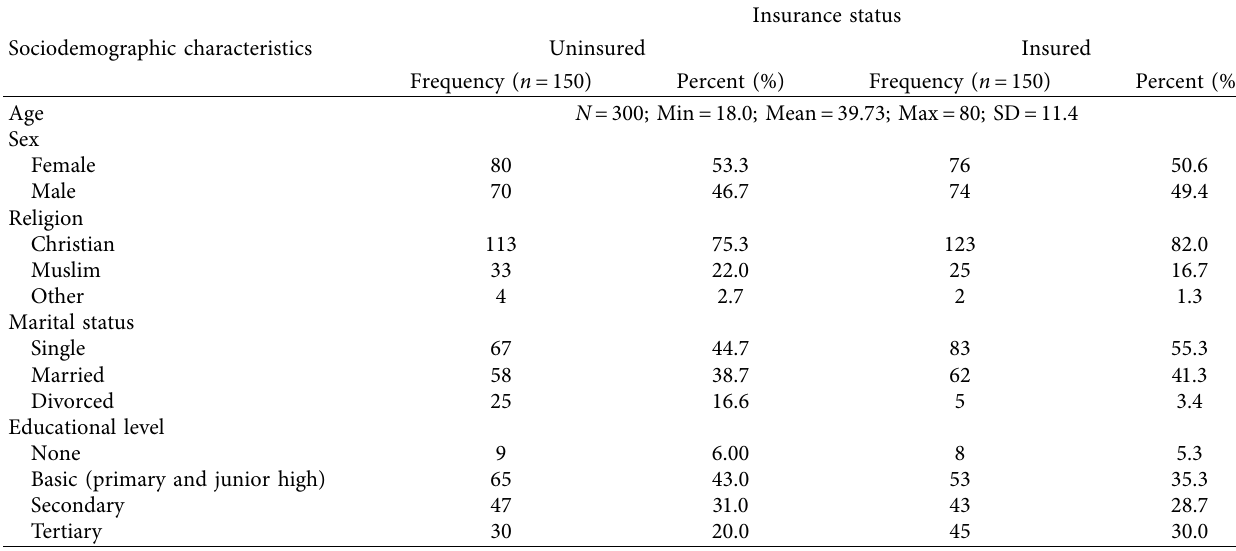
Table 1: Sociodemographic profle of patients.